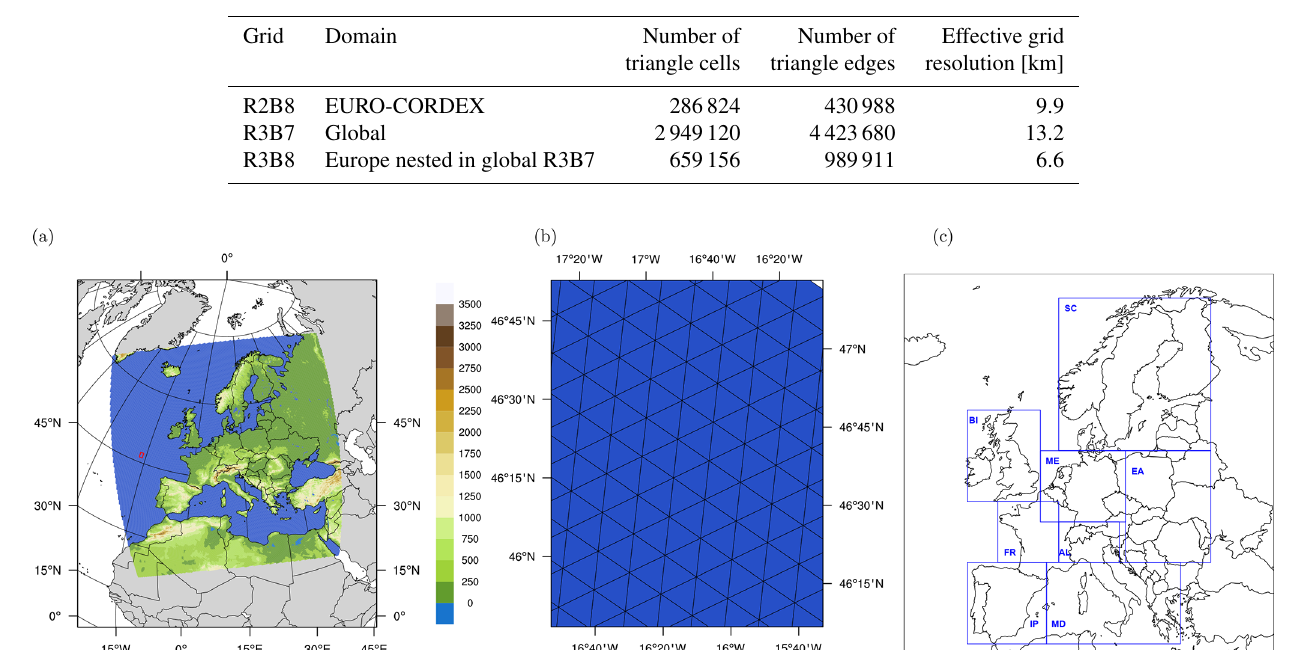
Table 1. Total numbers of triangle cells, edges and effective grid resolution of the grids mentioned in this paper.